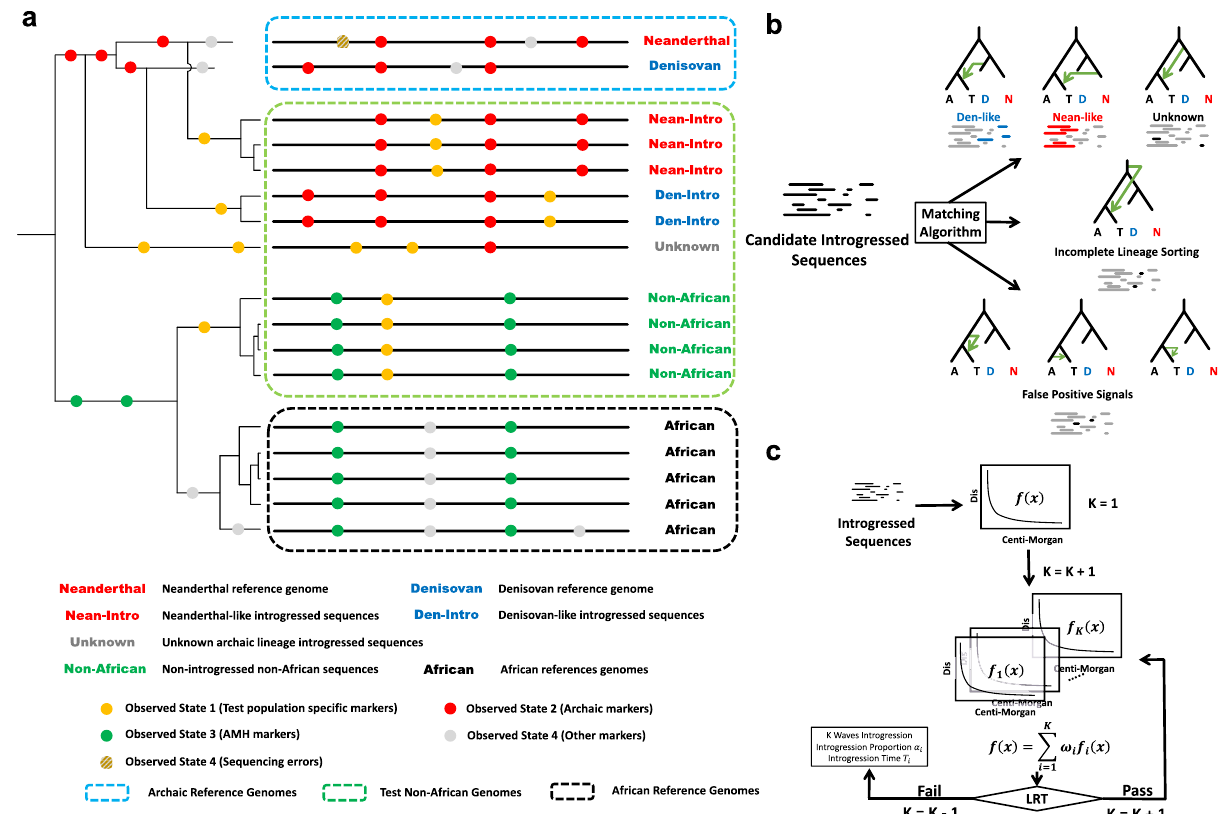
Fig. 1 ArchaicSeeker 2.0 schematic. a Seeking algorithm. The light blue dashed box includes archaic reference genomes, the light green dashed box includes tested non-African human genomes, and the black dashed box includes African reference genomes. Dots in different colors stand for mutations of four different observation states in the HMM. b Matching algorithm. After we got the candidate introgressed sequences, we matched them to the seven topologies and found the best-matched one. Each topology corresponds to introgression for one speci fi c lineage, incomplete lineage sorting, or a false- positive signal. c Reconstructing introgression history. For those introgressed sequences from one speci fi c lineage, the length distribution was used to reconstruct the introgression history. A likelihood ratio test was used to fi nd the most likely number of introgression events ( K ) and the software estimated introgression time and the proportion of each introgression event. AMH, anatomically modern